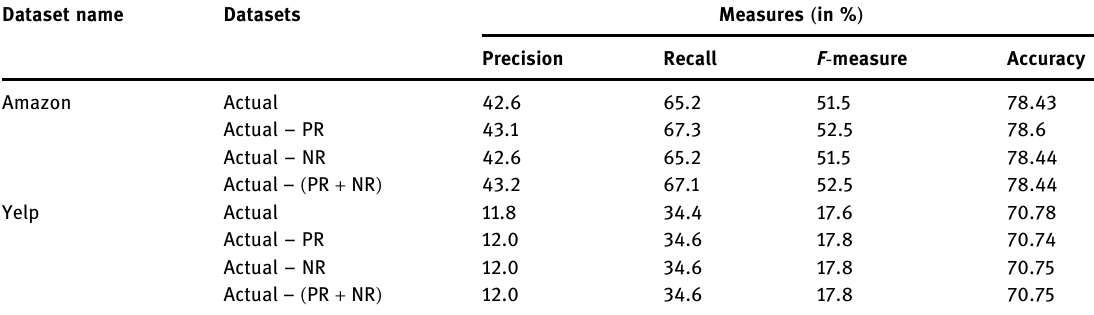
Table 5: Test dataset: 10% Dataset name